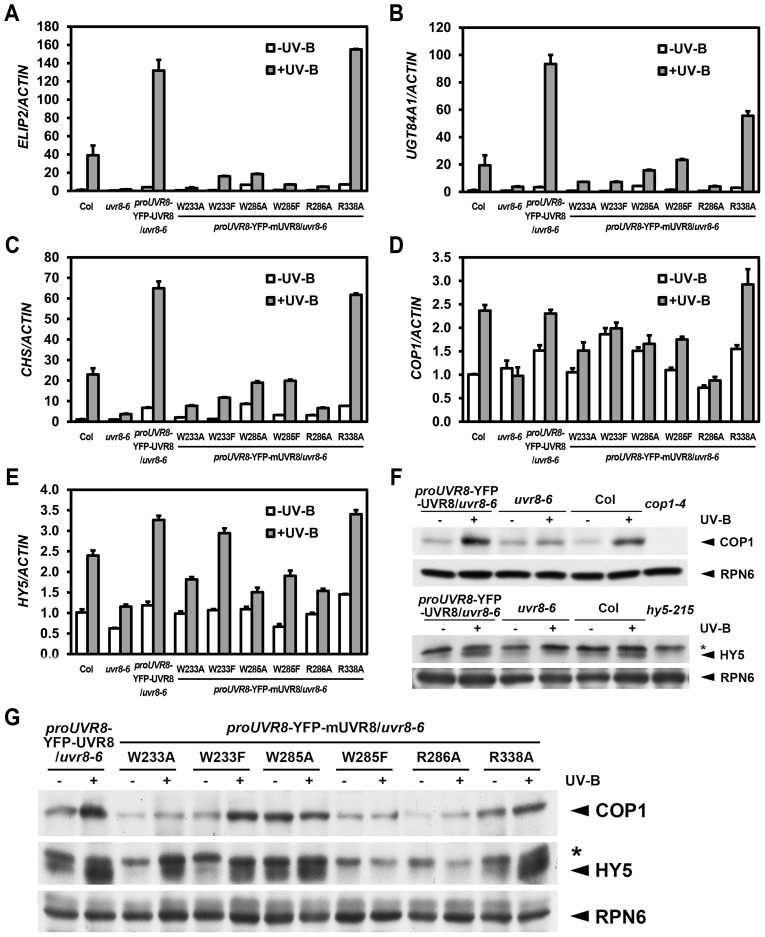
UVR8 mutations lead to abnormal UV-B-responsive gene expression.(A–E) qRT-PCR analysis of UV-B-responsive gene expression ELIP2 (A), UGT84A1 (B), CHS (C), COP1 (D) and HY5 (E) in 4-day-old seedlings grown under −UV-B and +UV-B. Data are shown as mean ± SD; n = 3. (F–G) Immunoblot assay of COP1 and HY5 proteins (by anti-COP1 and anti-HY5 antibodies) in 4-day-old seedlings grown under −UV-B and +UV-B. Anti-RPN6 was used as a loading control. The asterisk indicates an unspecific cross-reactive band.